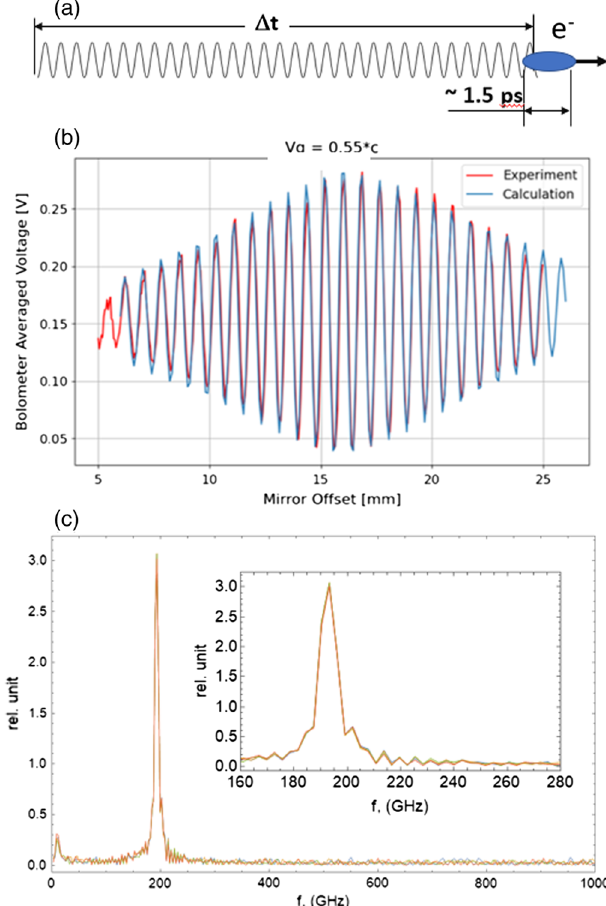
FIG. 13. (a) A qualitative illustration of the anticipated radi- ation. (b) The interferogram obtained when the electron bunch propagated through the CWG with the length L ¼ 34 mm. (c) The spectrum of the radiation emitted when the electron bunch propagated through the CWG with the length L ¼ 96